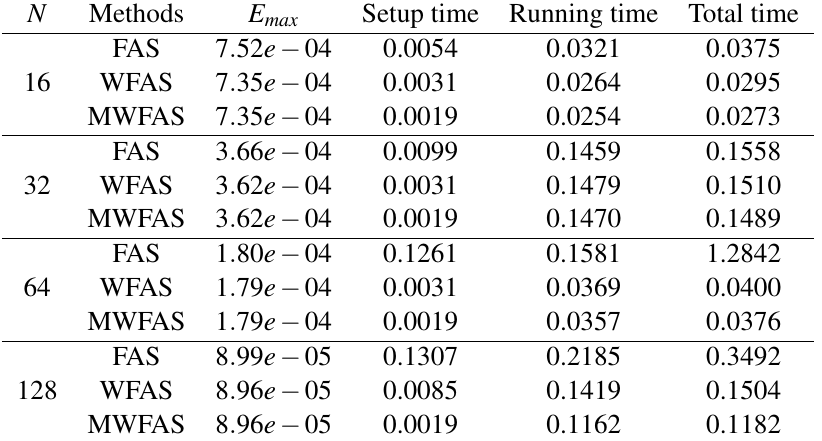
Table 2 Maximum error and CPU time (in seconds) of the methods of test problem